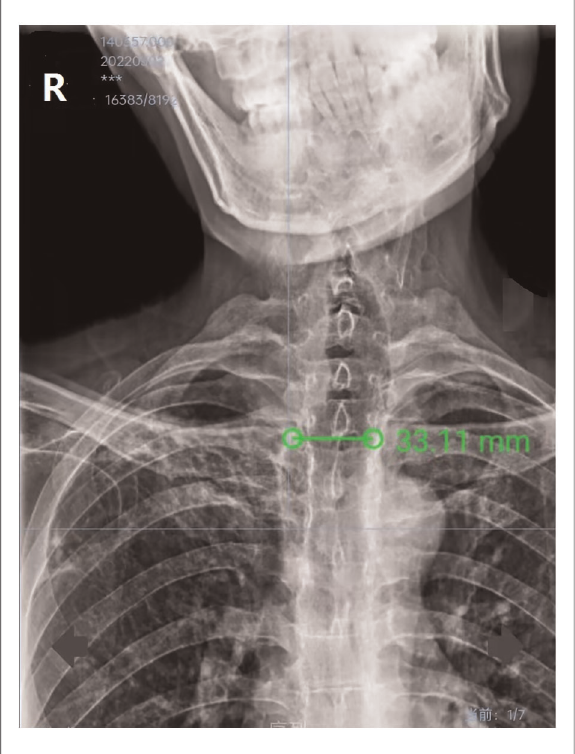
FIGURE 1 Preoperative thoracic digital radiography image showing that the transverse diameter of the trachea was 33 mm on the level of 2 cm above the aortic